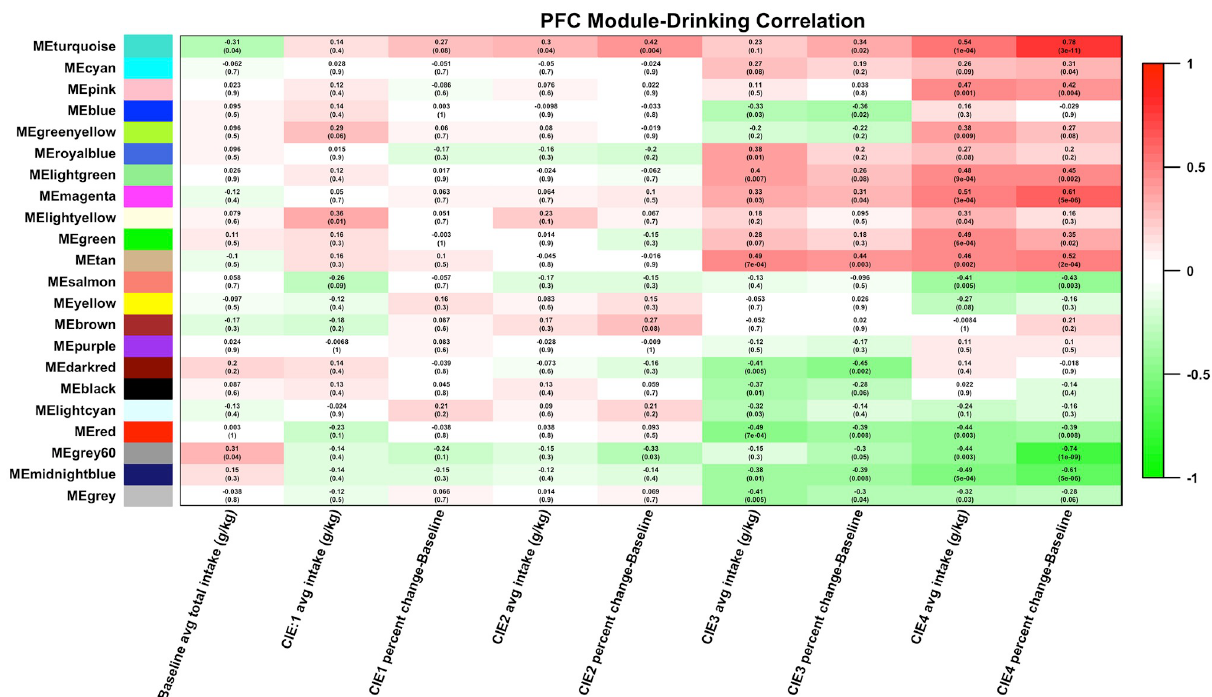
Fig 5. Heatmap of correlation between PFC modules and ethanol intake. Module eigengene (ME, 1st principal component of gene expression) values were correlated to ethanol intake measures. Cell color indicates strength of correlation (green = negative correlation, red = positive correlation).